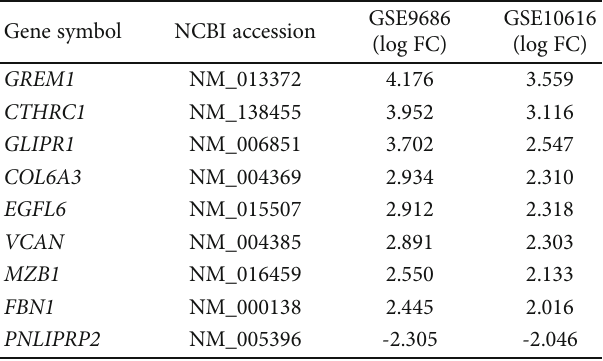
Figure 2: Expression levels of the receptors of predicted upstream regulators in pediatric ulcerative colitis. The expression levels are derived from the relative fl uorescence of each transcript on the microarray chips. ∗ P < 1 × 10 − 3 , ∗∗ P < 1 × 10 − 4 , ∗∗∗ P < 1 × 10 − 5 . IFNGR1: interferon gamma receptor 1; TNFRSF1B: tumor necrosis factor receptor superfamily member 1B; OSMR: oncostatin M receptor; IFNAR2: interferon alpha and beta receptor subunit 2; CSF2RA: colony-stimulating factor 2 receptor alpha subunit. Table 4: Potential new biomarkers in